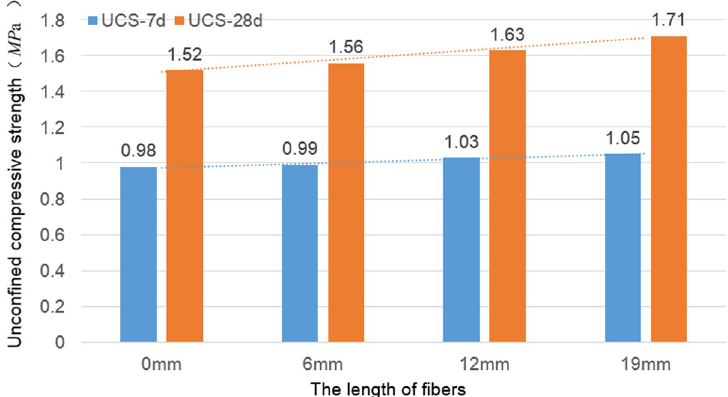
Fig 10. Results of unconfined compressive test with same N f . Under the same conditions, the unconfined compressive strength of the solidified soil slightly increased with the fiber content. The unconfined compressive strength of the solidified soil reinforced with 19 mm fibers was the